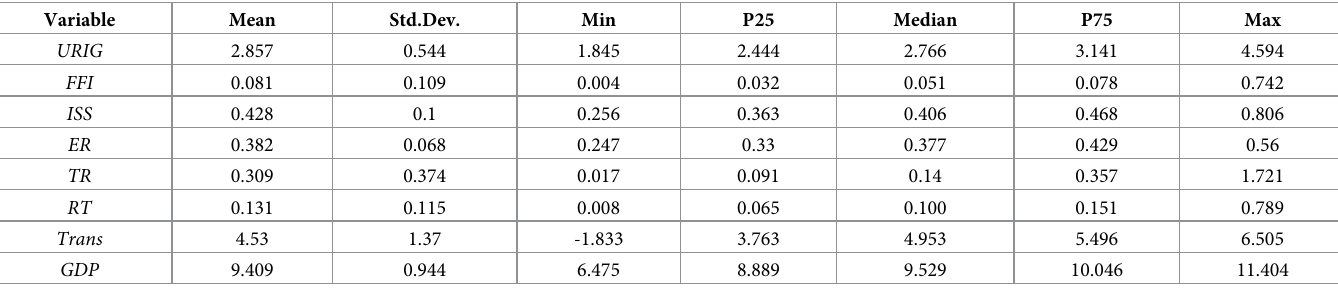
Table 4. Summary statistics for main